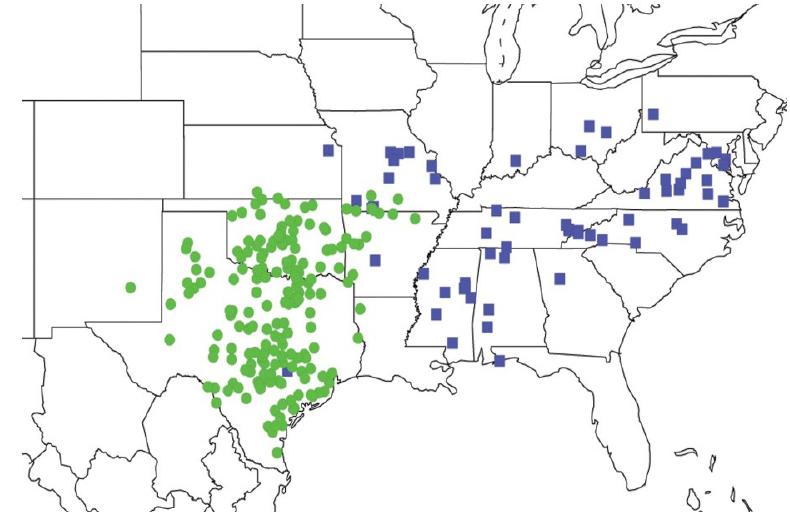
Figure 16. Distribution of Tibicen robinsonianus (blue squares) and T. superbus (green